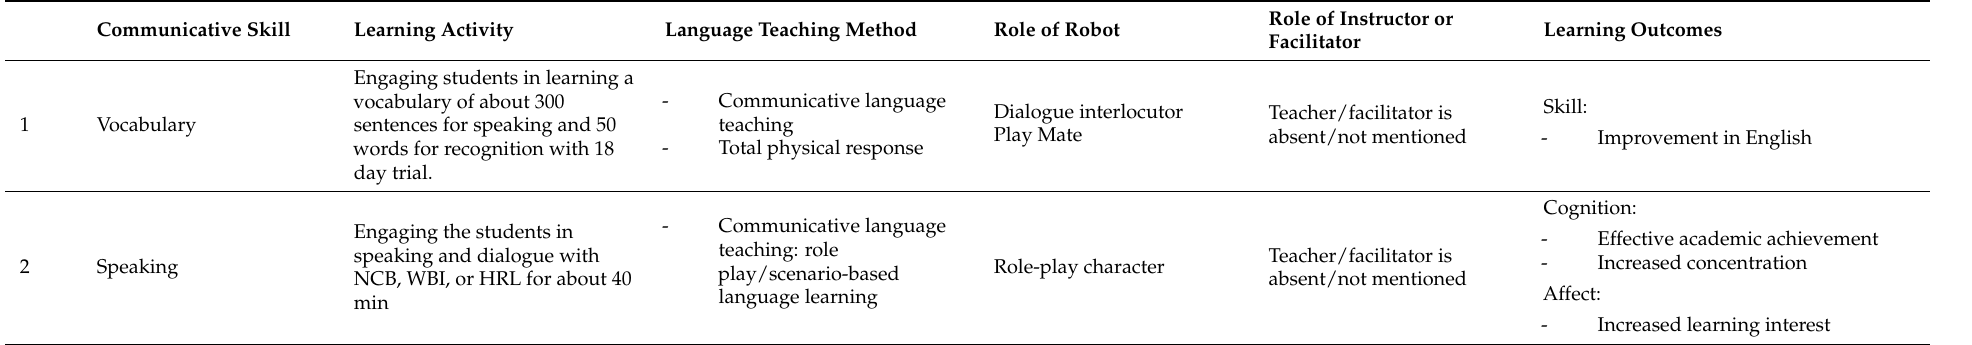
Table A2. Instructional Design and Learning Outcome of